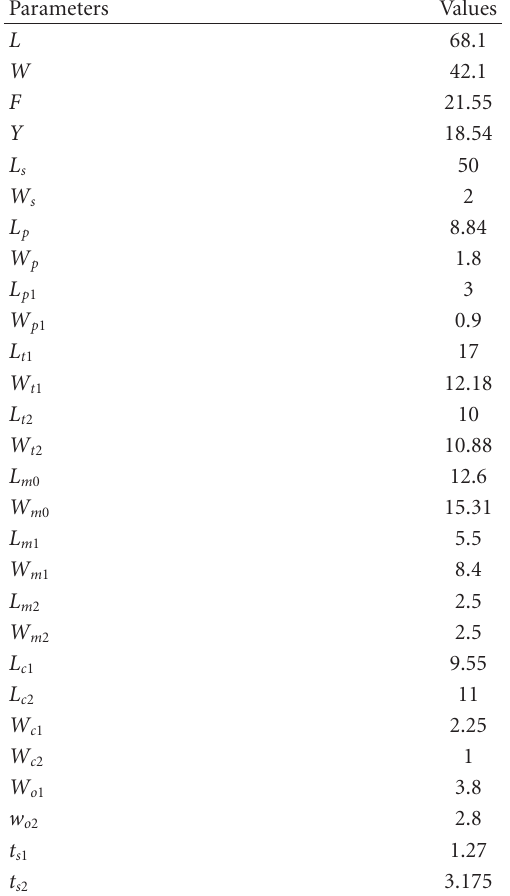
Table 1: Design parameters of the MSA-BP (mm).